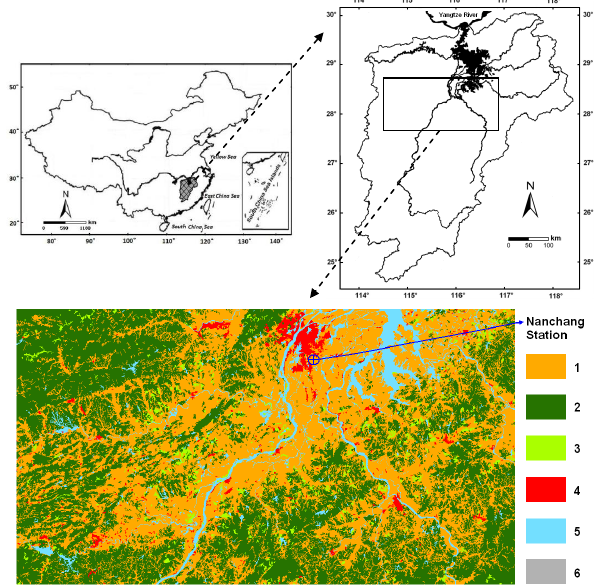
Fig. 3. Geographical location of the study area (up) and land cover map of the study area (down). Poyang lake basin is located in southeast of China and a relatively flat region within the basin is selected as our study area. The yearly land cover classification map in 2005 was provided by the “Data sharing Network of Earth System Science, Chinese Academy of Sciences”. 1 = cropland, 2 = forest, 3 = grassland, 4 = urban areas, 5 = water, 6 = bare soil. The location of the Nanchang Ecological Experimental station is also shown in the land cover map.